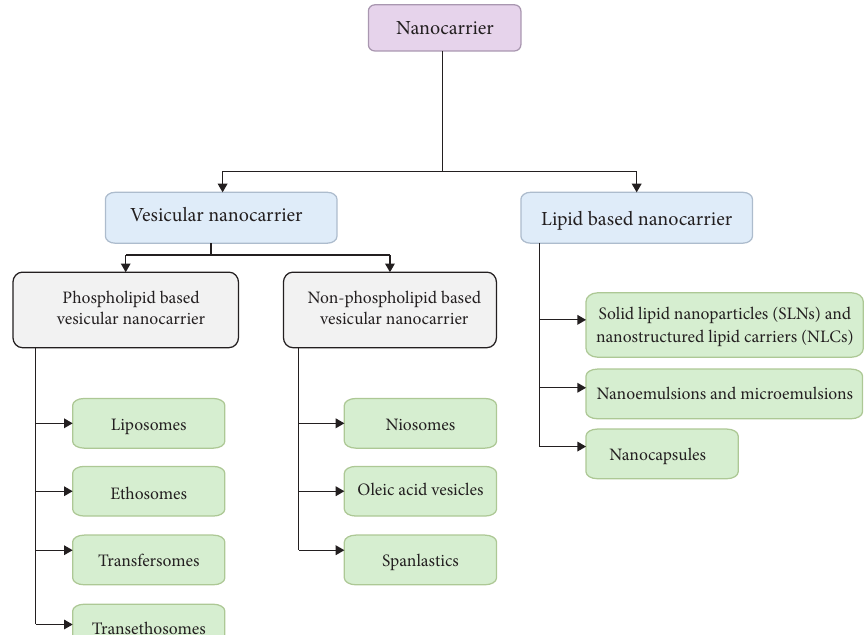
Figure 10: Classification of